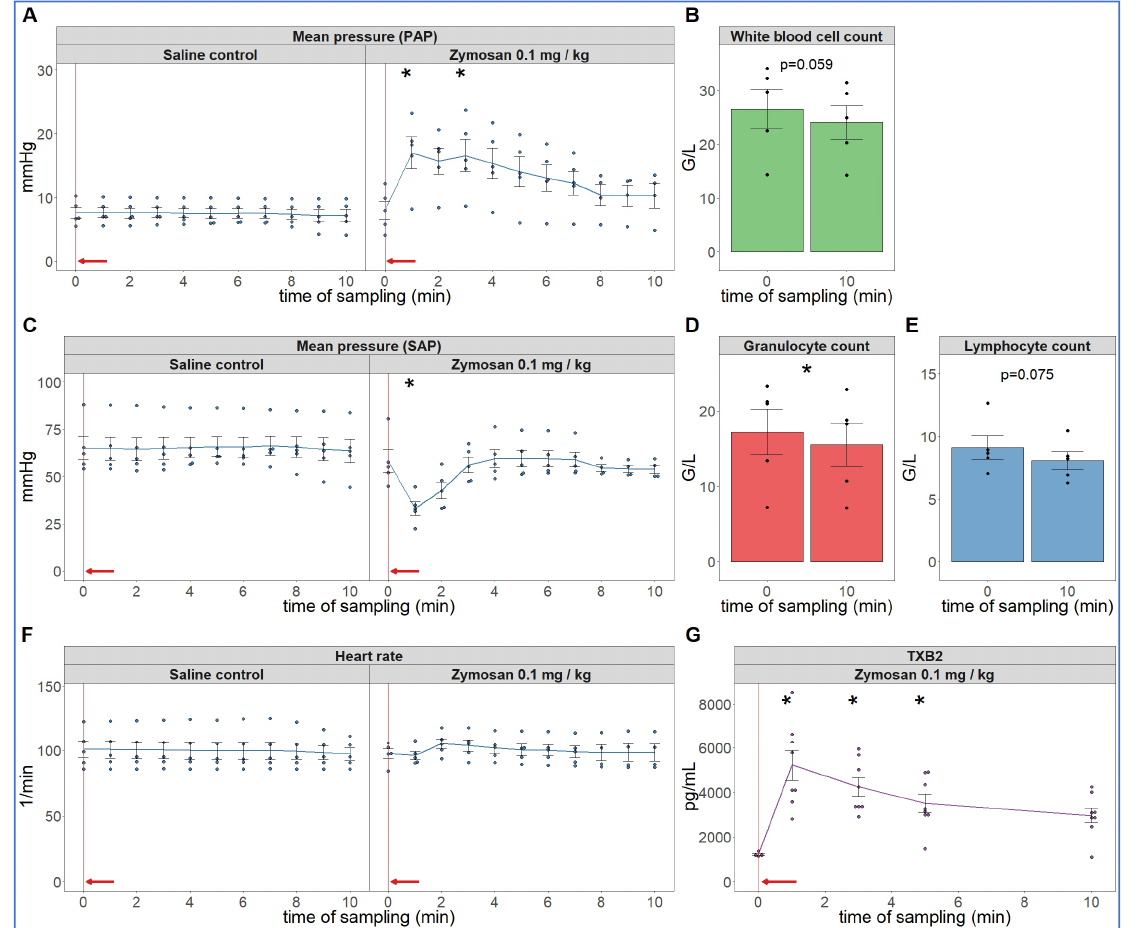
Figure 1. Physiological changes caused by bolus injection of 0.1 mg/kg zymosan in pigs. In ( A , C , F ) the PAP, SAP and HR were continuously recorded, and the coinciding values were averaged (±SEM) in four animals every minute over 10 min both before and after the zymosan injection. Zymosan administration is marked with red arrow. Blood white blood cell count ( B ), granulocytes ( D ) and lymphocytes ( E ) were counted in a coulter counter at 10 min after zymosan injection and were related to their respective baseline, i.e., the last blood collection before the zymosan injection (0 min). TXB2 increased 4-fold within a minute after zymosan administration ( G ). G/L means cell number × 10 6 /L, * p < 0.05 relative to respective baselines (0 min), determined using paired t -test.